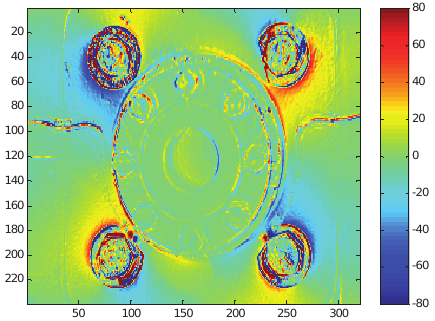
Fig. 12. TSA obtained for the load of bending in